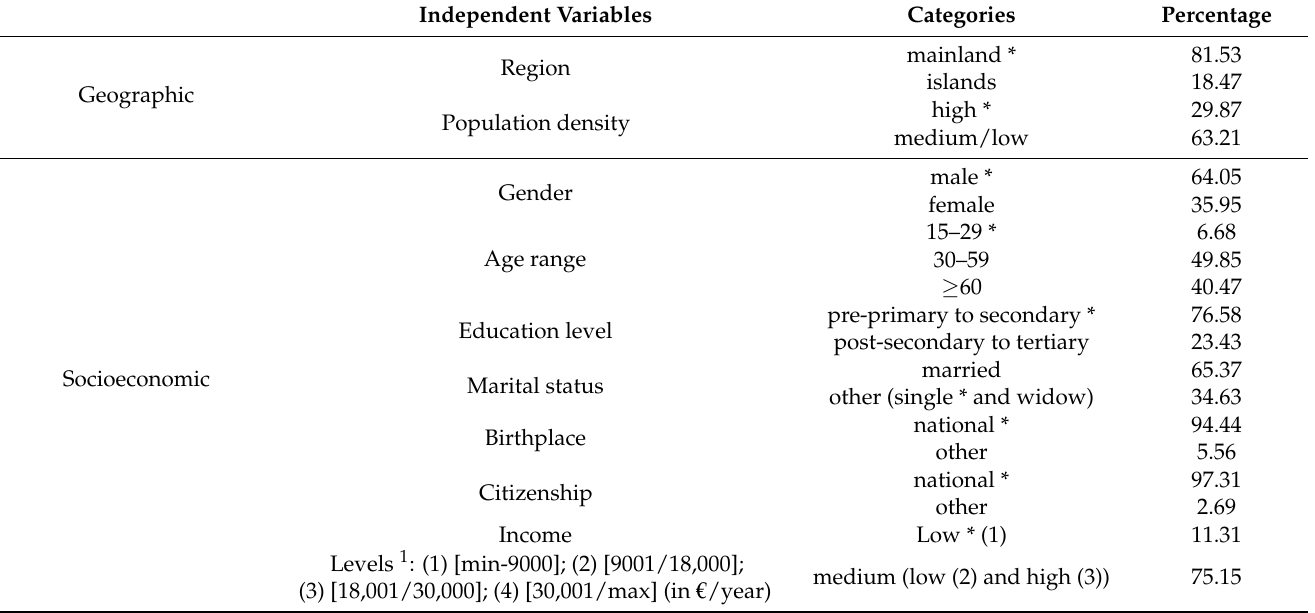
Table 2. Summary